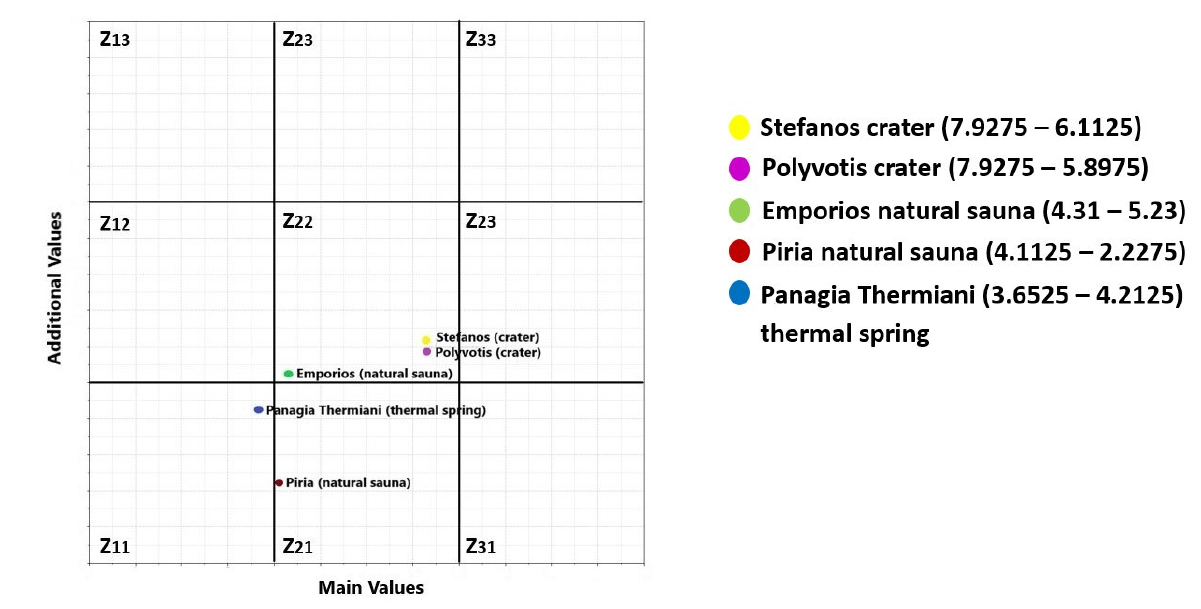
Table 8. Final results of the application of the M-GAM method.